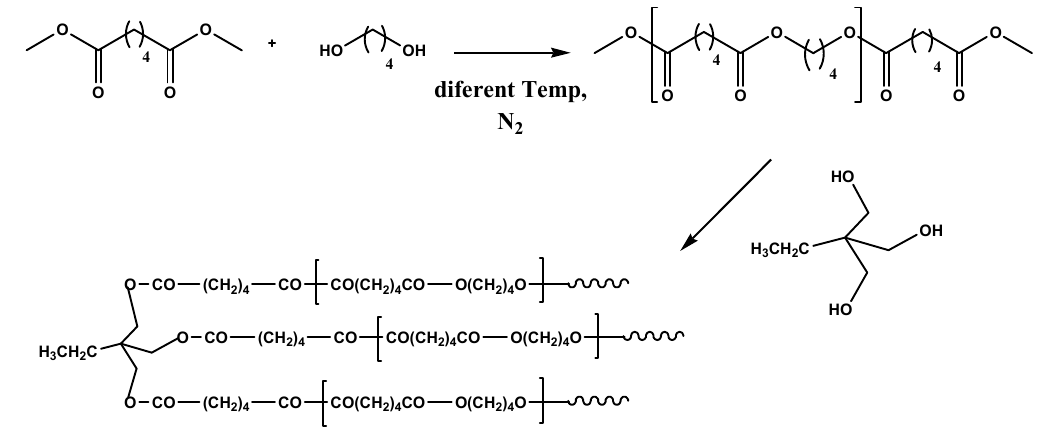
Figure 2. Synthesis of linear-hyperbranched hybrid poly(butylene adipate) copolymers, based on [65].